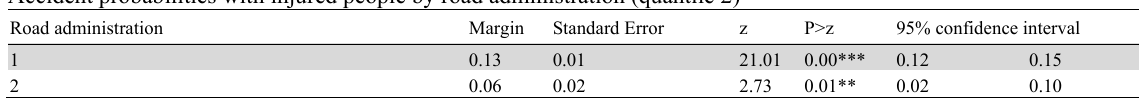
Accident probabilities with injured people by road administration (quantile 2) Road administration Margin